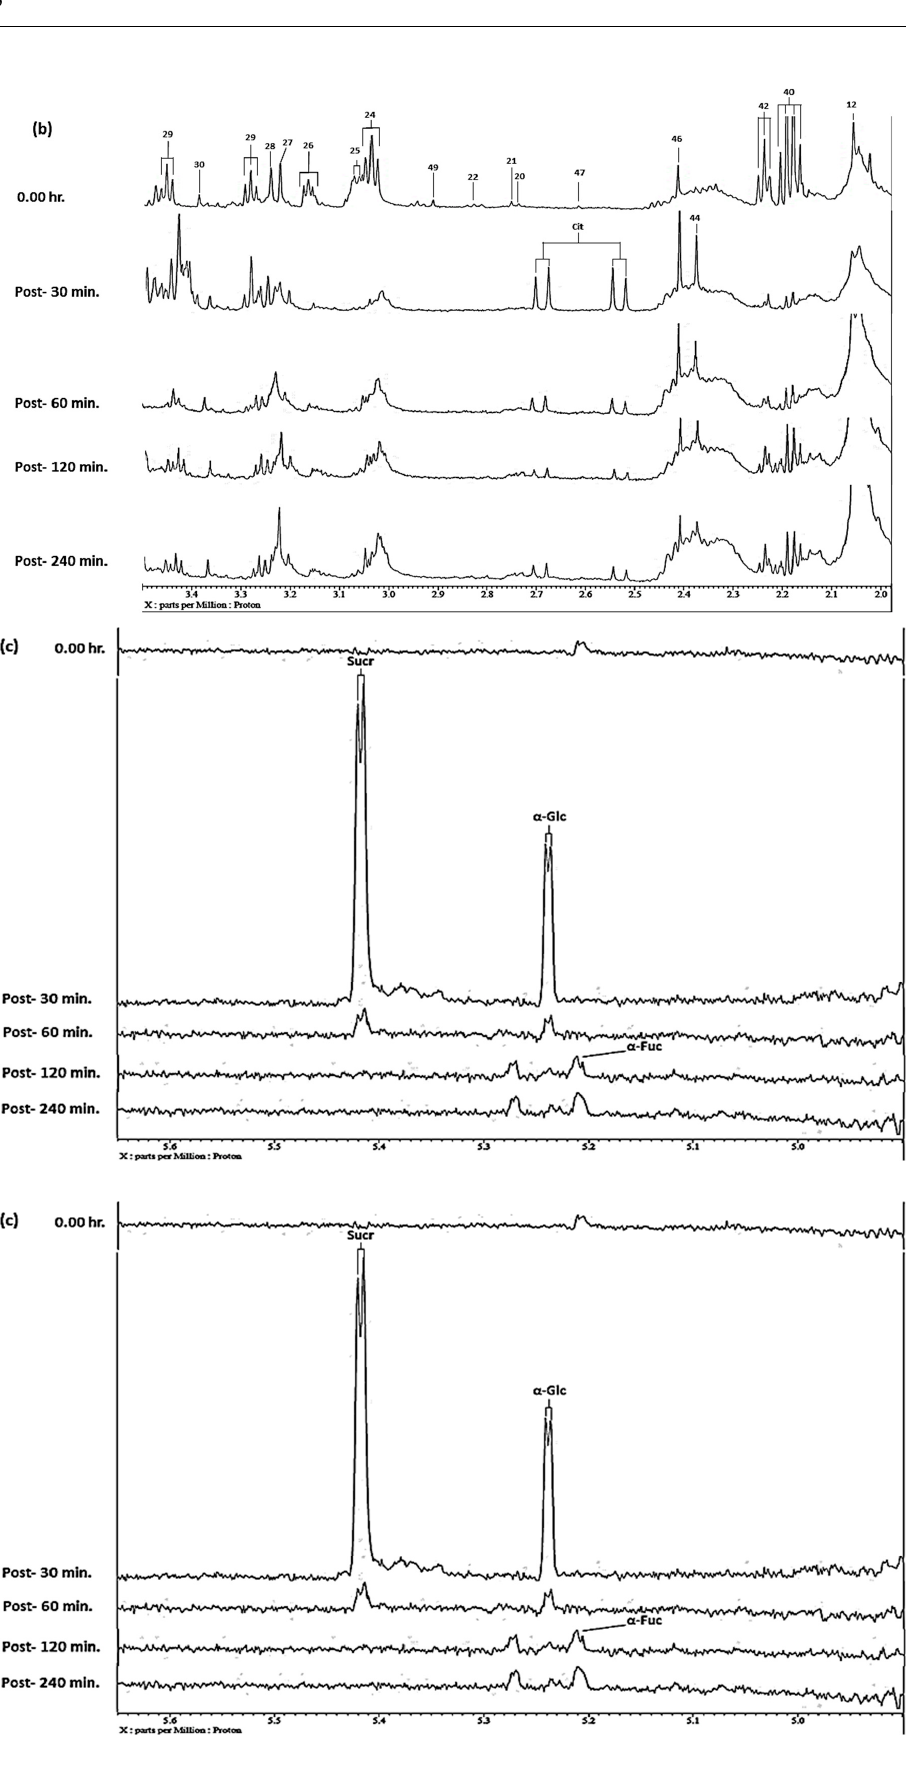
Figure 2. ( a – d ), Partial 1.00–2.00, 2.00–3.50, 4.90–5.65, and 6.56–9.00 ppm regions of the 600 MHz WASTED 1 H NMR profiles, respectively, of WMS supernatant samples collected from a healthy human participant immediately before (0.00 h) and at 0.50, 1.00, 2.00, and 4.00 h following the con- sumption of a ‘real-life’ single vegetarian sandwich meal. Resonance code assignments correspond to those listed in Table 1, although α -Fuc, α -Glc, and Sucr represent α -fucose, α -glucose, and su- crose, respectively. The blue arrows in the post-eating 240 min spectrum shown in ( d ) indicate the evolution of broad resonances assignable to biomacromolecules, potentially aromatic amino acid residues present in salivary proteins. 1 H NMR spectra were recorded on a Jeol JNM-ECZ600R/S1 600 MHz spectrometer operating at frequency of 600.17 MHz, with a probe operating temperature of 25°C. Spectra were acquired with suppression of the very intense H 2 O/HOD resonance ( δ = 4.80